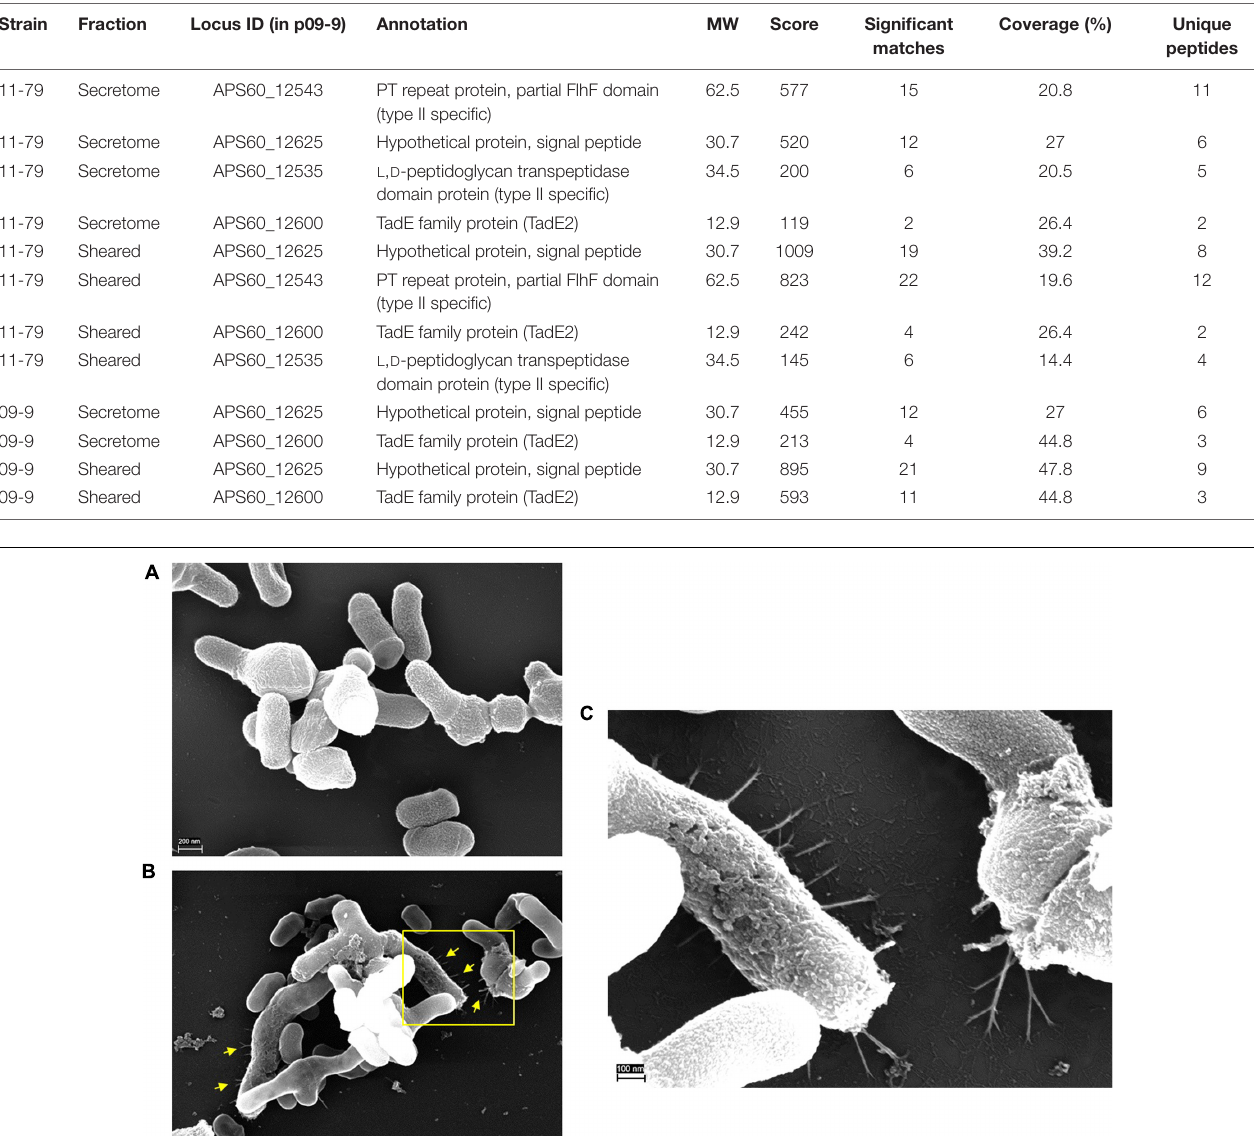
TABLE 4 | Identification of plasmid-encoded proteins in secreted and surface sheared fractions of two C. acnes strains. Strain Fraction Locus ID (in p09-9)